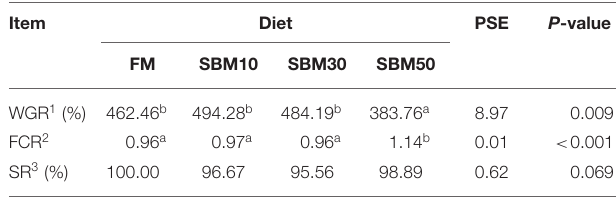
TABLE 2 | Growth indexes of hybrid grouper juveniles fed with different diets for 10 weeks.